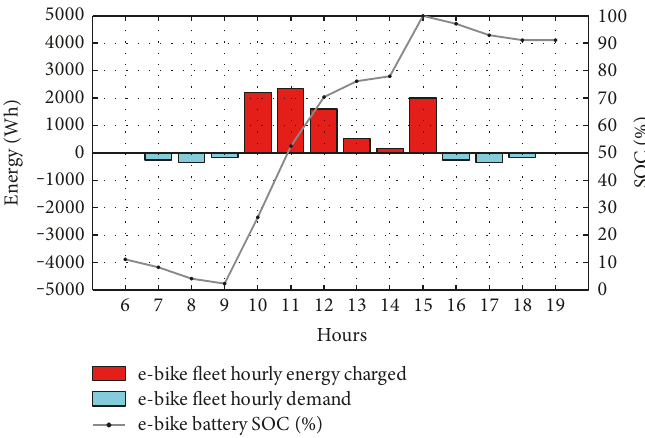
Figure 14: e-bike charging and discharging process and SOC